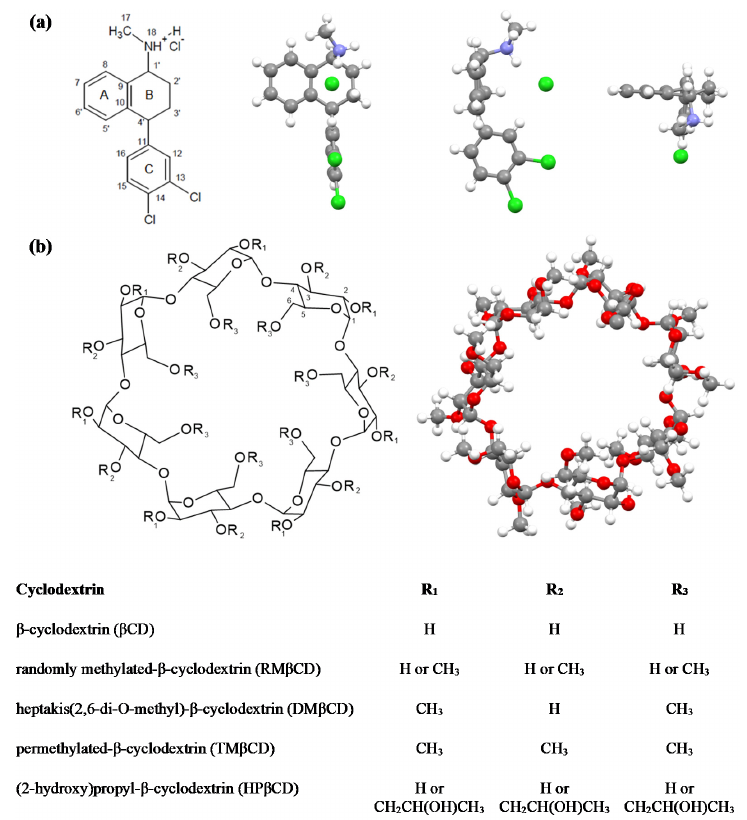
Figure 1. ( a ) Sertraline hydrochloride structural formula (on the left ) and the models made based on crystal structure of sertraline hydrochloride (on the right ) with refcode CAVVUQ [46] from the Cambridge Structural Database (CSD) [47] and ( b ) a general structural formula of some β -cyclodex- trins (on the left ) and crystal structure of RM β CD (on the right ) with refcode JOSWOD [48] from the CSD [47].